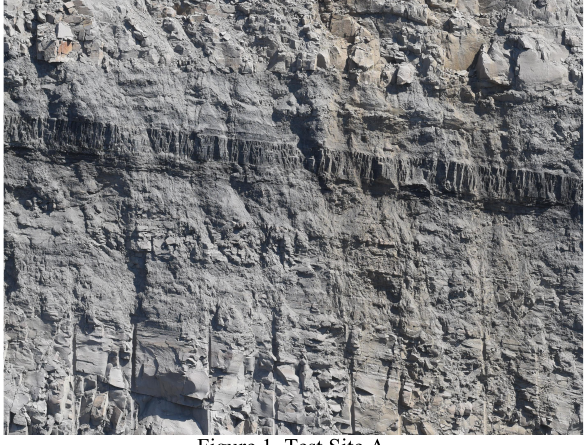
Figure 1. Test Site A.